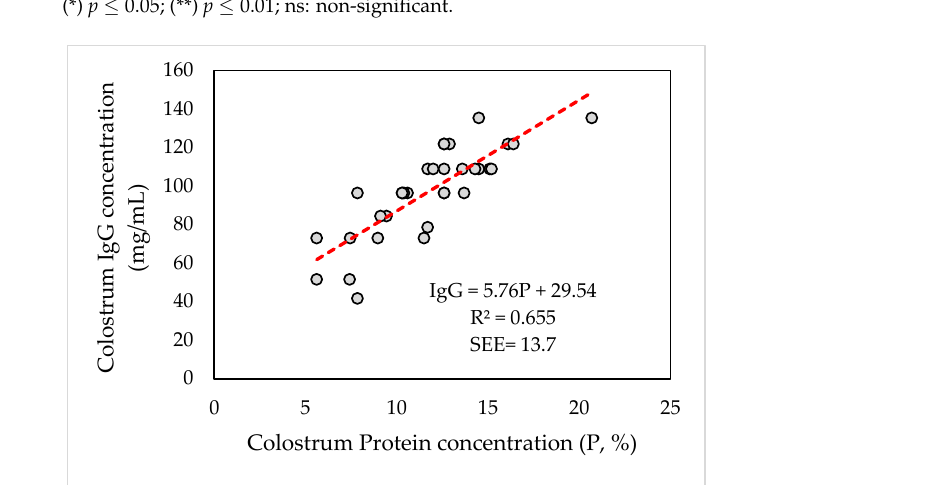
Figure 3. Relationship between IgG concentration (mg/mL) and protein concentration (P, %) in the colostrum of Merino Precoz ewes.